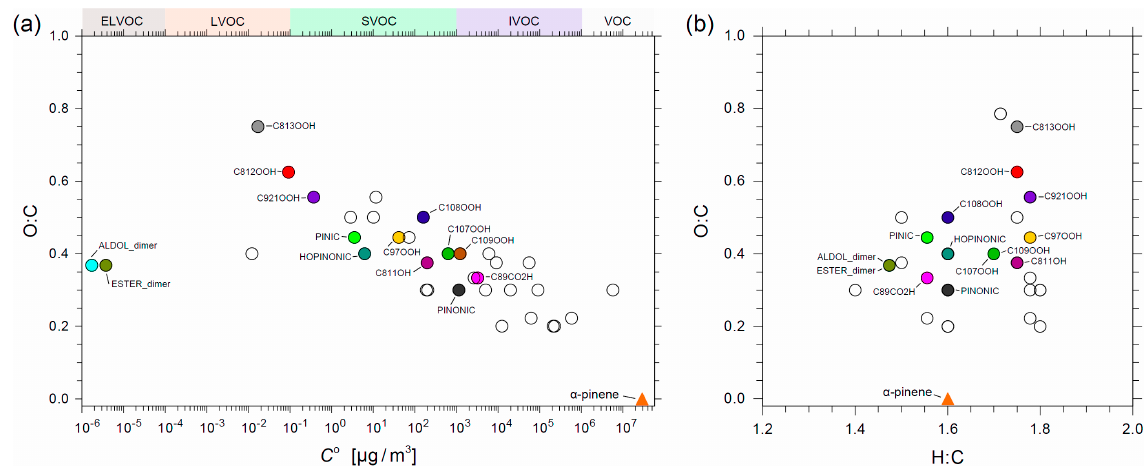
Fig. 2. (a) O:C ratio vs. volatility and (b) van Krevelen diagram (inverted) of organic compounds produced by the dark ozonolysis and further oxidation of α -pinene. Solid colored circles show the components of the model system, open circles indicate other oxidation products of α - pinene as predicted by MCM 3.1 for different chamber operation conditions or products at higher volatilities (IVOCs) that almost entirely reside in the gas phase (Shilling et al., 2009; Camredon et al., 2010). Pure compound saturation concentrations ( C ◦ ) are calculated with the EVAPORATION model (Compernolle et al.,